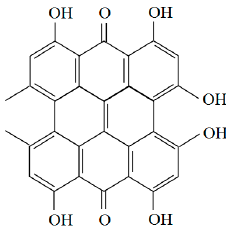
Figure 2. Structure of hypericin.